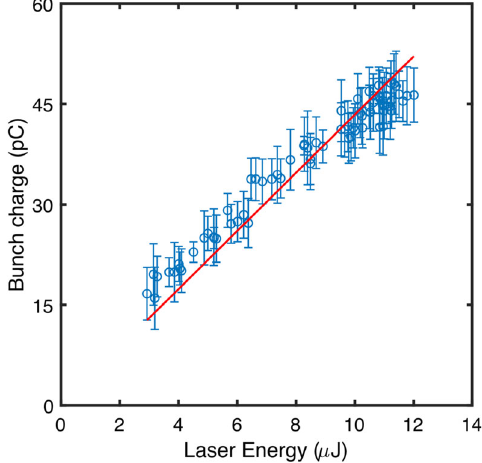
FIG. 6. Collected charge as a function of the laser energy. The solid red line is the linear fit curve. QE ¼ ð 1 . 3 (cid:3) 0 . 3 Þ × 10 − 5 .